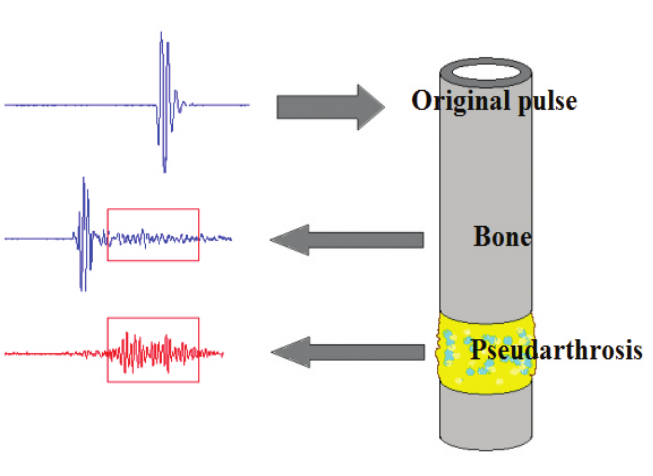
FIGURE 6 - Digital radiography (20kV, 0.41mA and 180s) with presence of tissue of nonunion